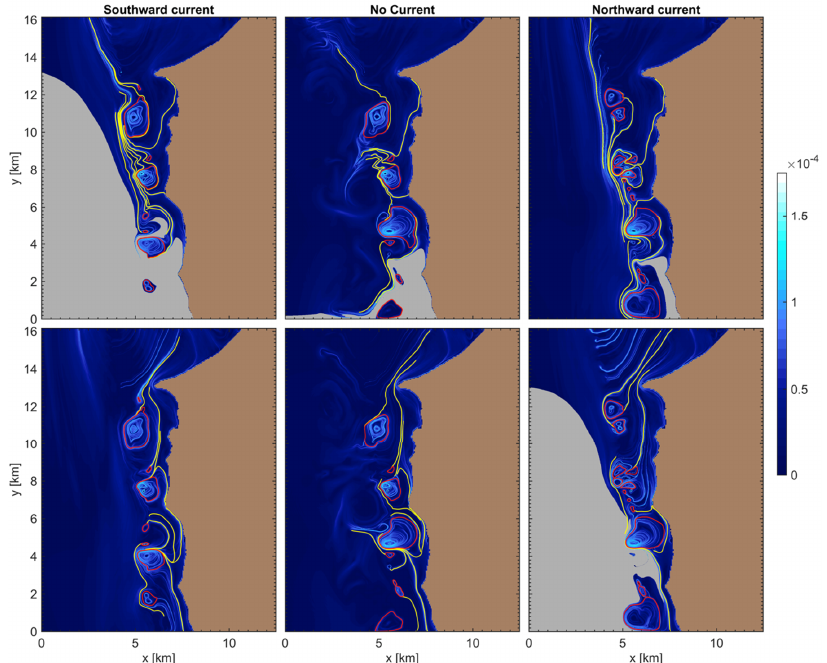
Figure A2. Sensitivity of LCS to offshore current. The ( top ) forward and ( bottom ) backward FLTE fields for a 2 m offshore wave height and southward offshore current ( left ), no offshore current ( center ), and northward offshore current ( right ). Plotted are the hyperbolic (yellow) and elliptic (red) LCSs; the hyperbolic are either ( top ) repelling LCS at the initial time t 0 or ( bottom ) the attracting LCSs at the final time t 1 , while the elliptic LCS mark the boundaries of Lagrangian eddies at both initial and final times.